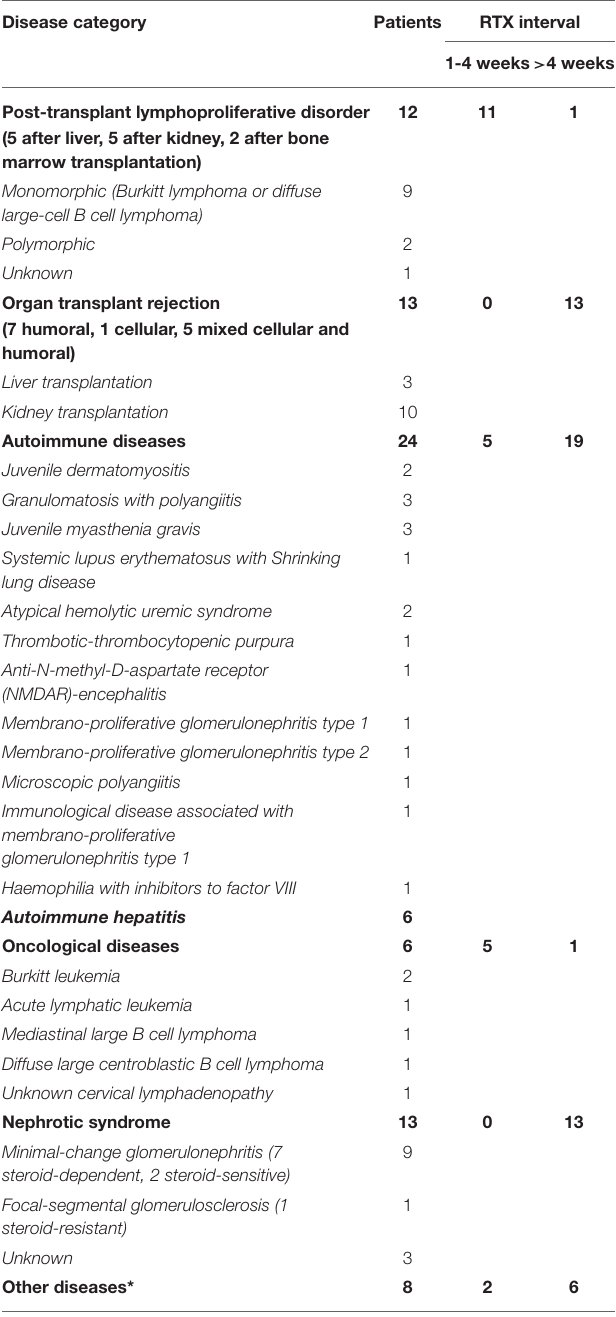
TABLE 1 | Patient cohort and different RTX regimes ( n = 76). Disease